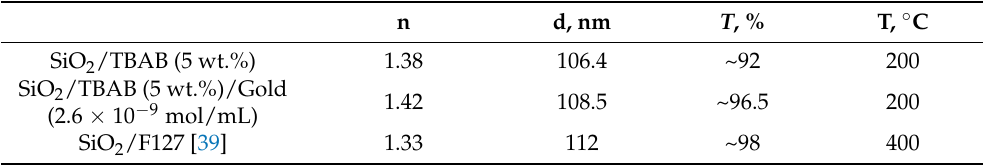
Table 1. Thickness and refractive index of films based on SiO 2 /TBAB, SiO 2 /TBAB/gold and SiO 2 /F127. n d, nm T , % T, ◦ C SiO 2 /TBAB (5 wt.%) 1.38 106.4 ~92 200 SiO 2 /TBAB (5 wt.%)/Gold 1.42 108.5 ~96.5 200 (2.6 × 10 − 9 mol/mL) SiO 2 /F127 [39] 1.33